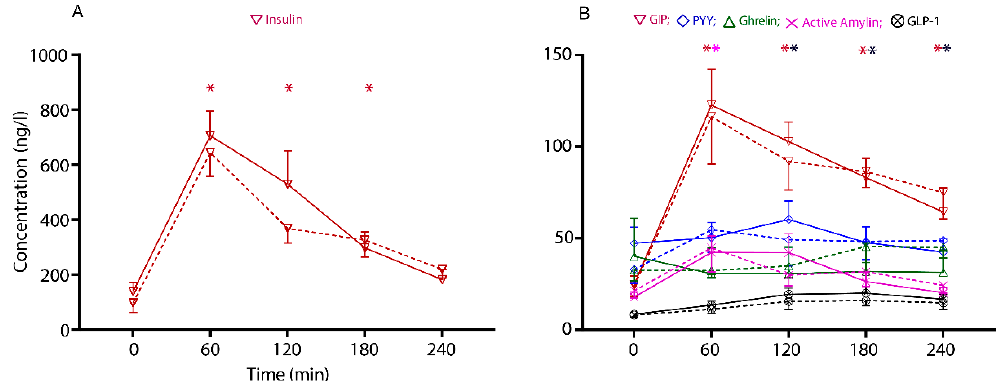
Figure 3. The circulatory concentration of gastrointensinal (GI) hormones across the intervention period in response to the two treatment arms, SV: Sous-vide (solid lines); PF: pan-fried (dashed lines). The values are presented as mean ± SEM of: ( A ) Insulin (ng/L), and ( B ) GIP: gastric inhibitory protein, PYY: peptide tyrosine-tyrosine, ghrelin, active amylin and GLP-1: glucagon-like protein-1 (ng/L). Comparisons between the two cooking methods and interactions with time points (time × cooking methods) were conducted with linear mixed-effects model analysis. * The times at which the hormone concentrations significantly differed from the baseline ( p < 0.05, posthoc is relevant to the main time effect only).